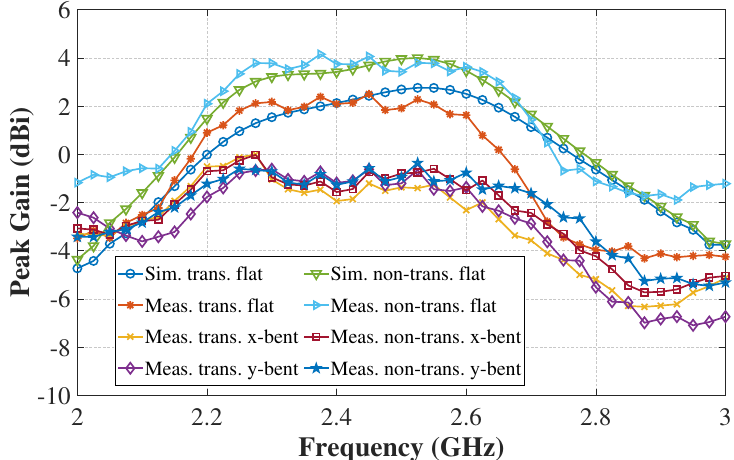
Figure 24. Simulated and measured peak gain vs. frequency of the transparent and non-transparent antennas.